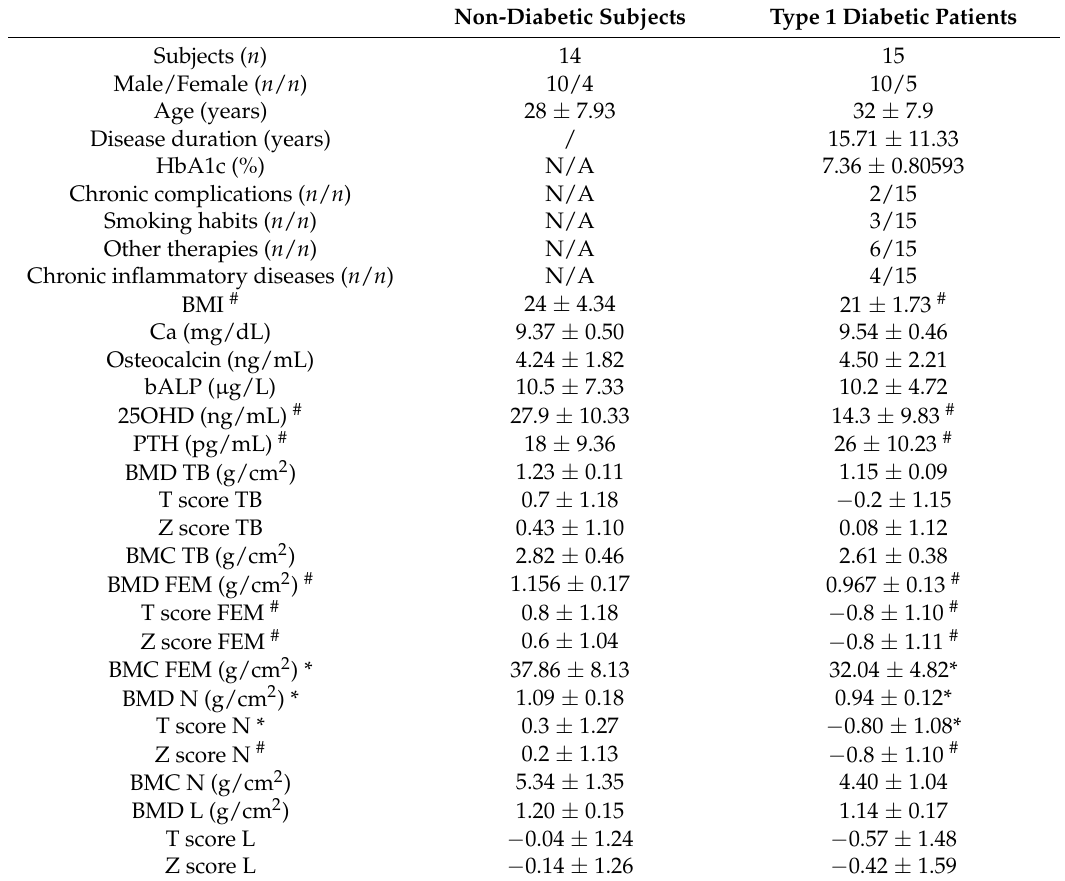
Table 2. Main clinical characteristics of non-diabetic subjects and type 1 diabetic